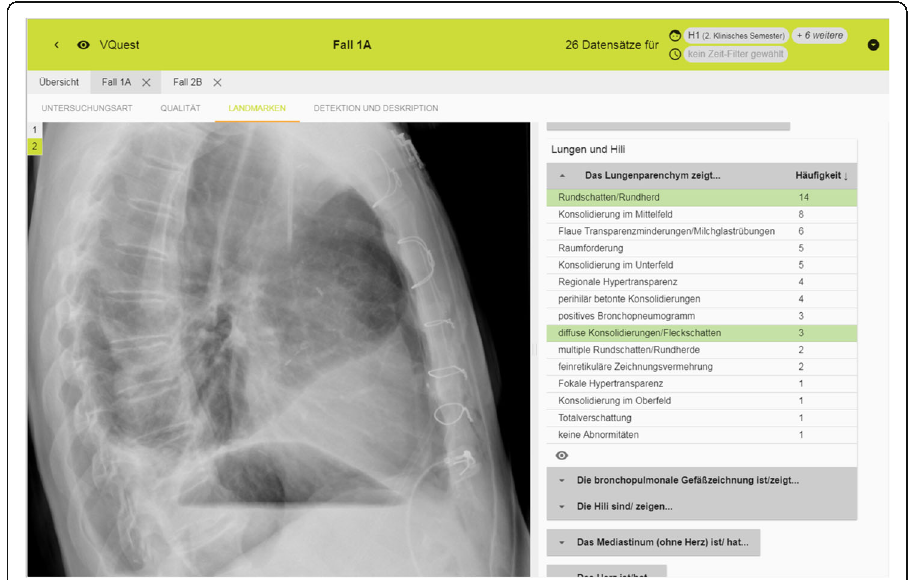
invisible with the “ hide correct answer ” button (eye